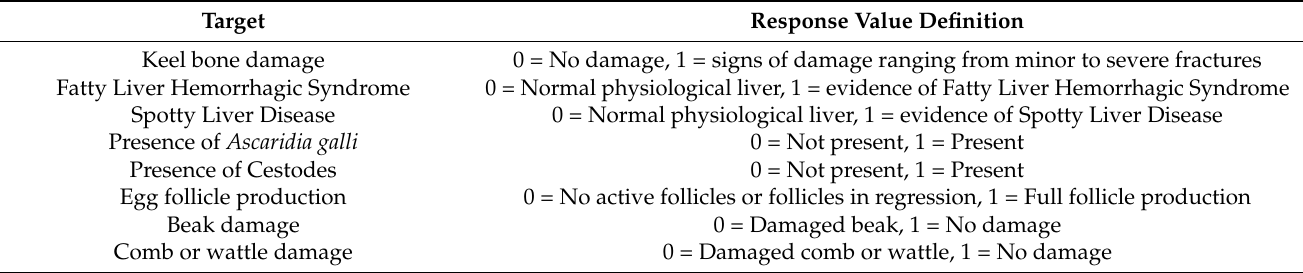
Table 1. The definition of the response/target variables and classes used for the machine learn- ing